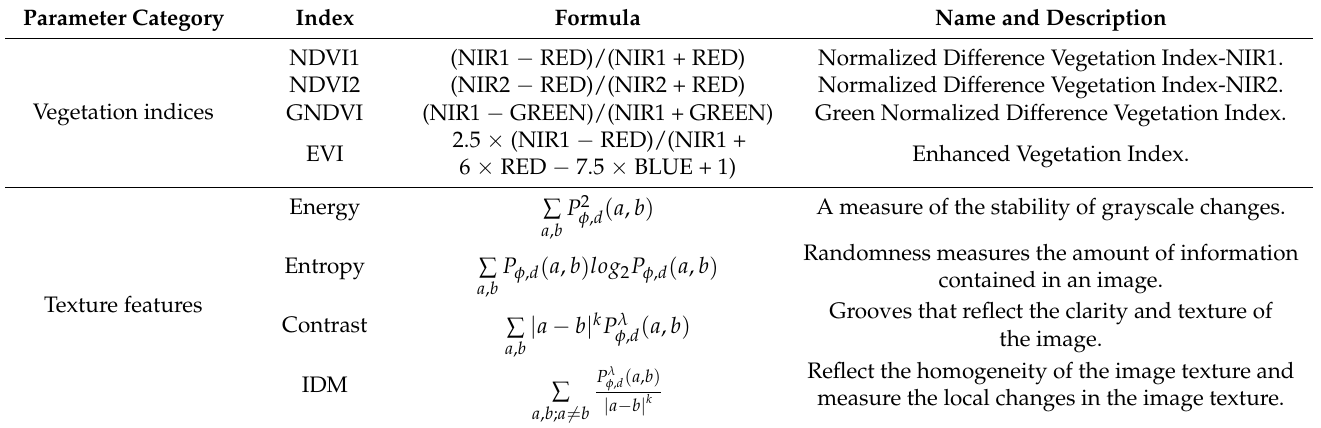
Table 3. List of vegetation indices and texture